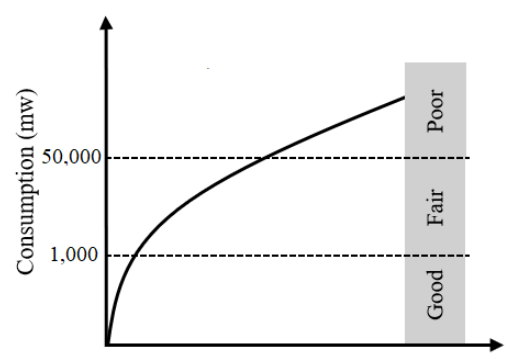
Figure 3. Evaluation grid of the power